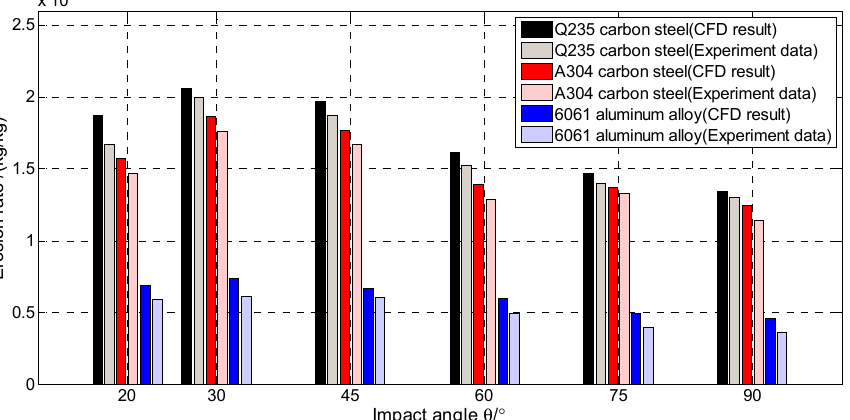
Figure 18. The comparison diagram denoting the erosion rates of the CFD simulation and experimental data at different particle velocities (Q235 carbon steel and particle size d p = 300 μ m).